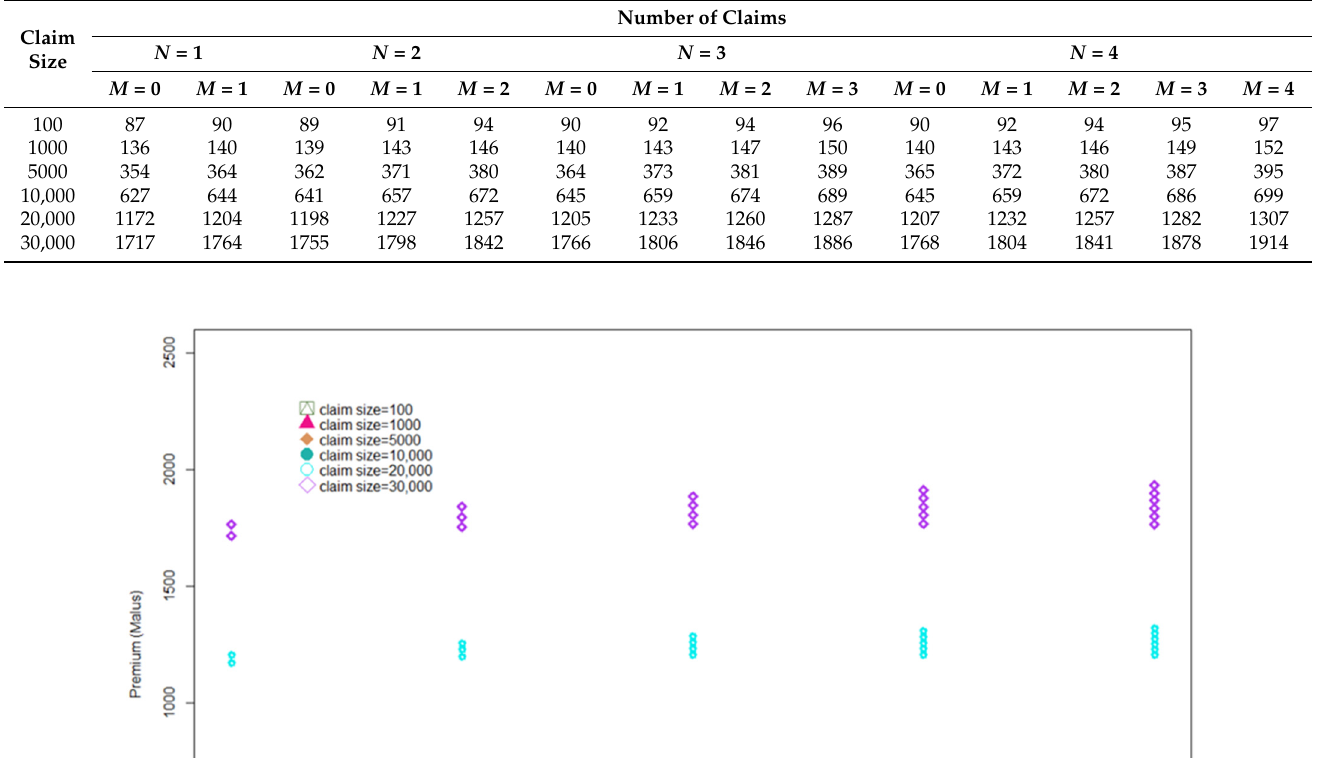
Table 11. Comparison of premiums for various number of claims and claim sizes in the first year.